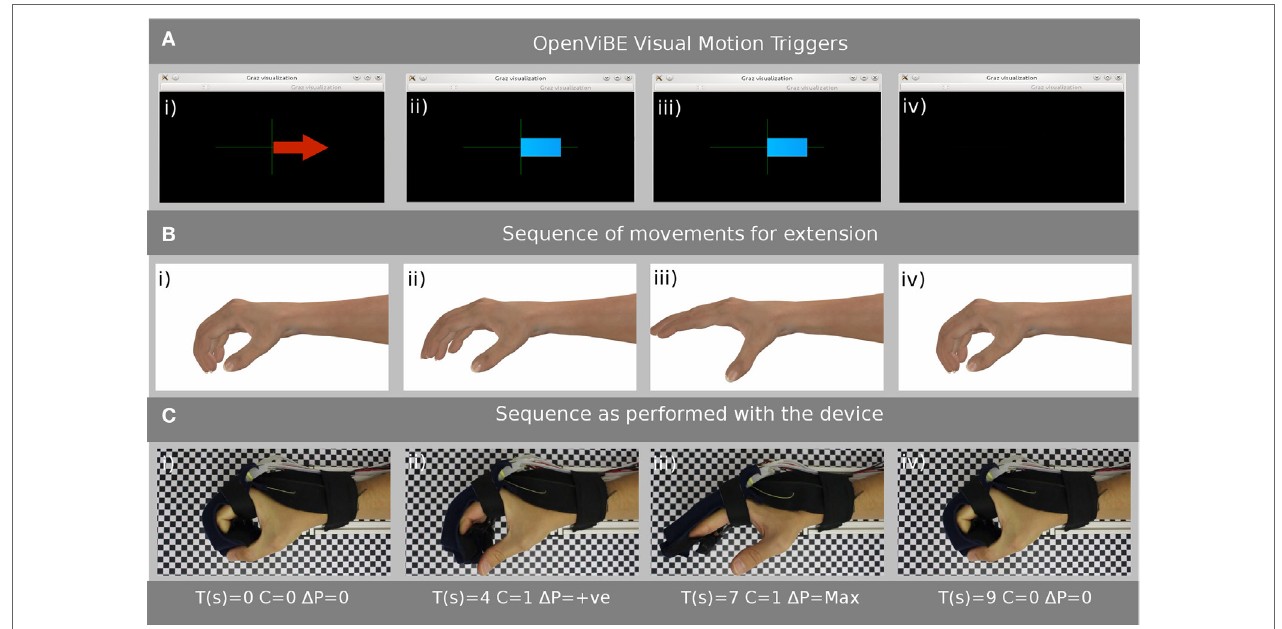
FigUre 6 | (a) Samples of the Graz Visualization that the subject will see on the display and proceeds from (i) where the arrow indicates the subject should think “open hand” (ii) and (iii) show the classifier signal level (before the binary thresholding), which in this example should stay to the right of the axis, (iv) indicates that the subject should relax and think of “nothing.” (B) An example of the simulated motion the patient should be performing while the exercise is proceeding. (c) Shows the subjects hand, while wearing the glove, and the corresponding time ( T ), thresholded classifier value ( C ), and the change in pressure ( Δ P ) as the exercise proceeds from (i) to